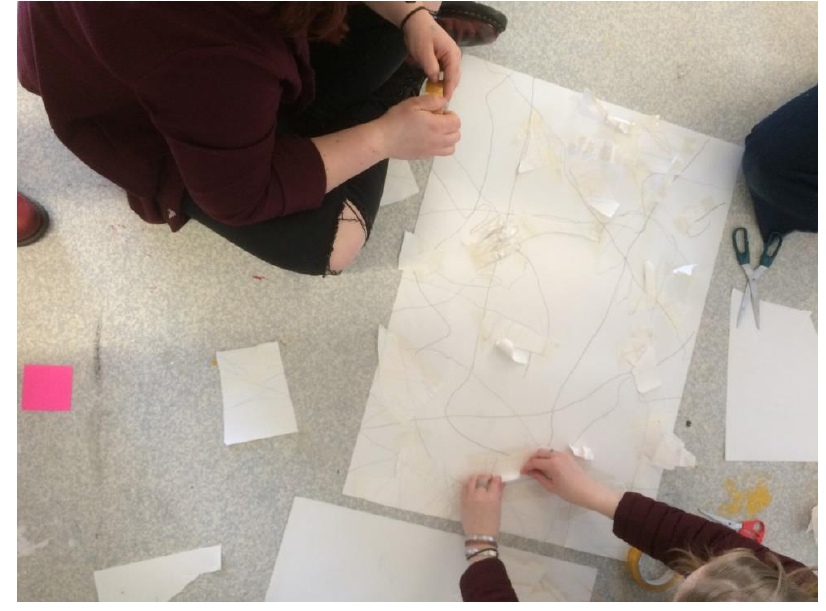
Figure 3. Thomas, J (2018). Undergraduate students collaboratively problem solving.